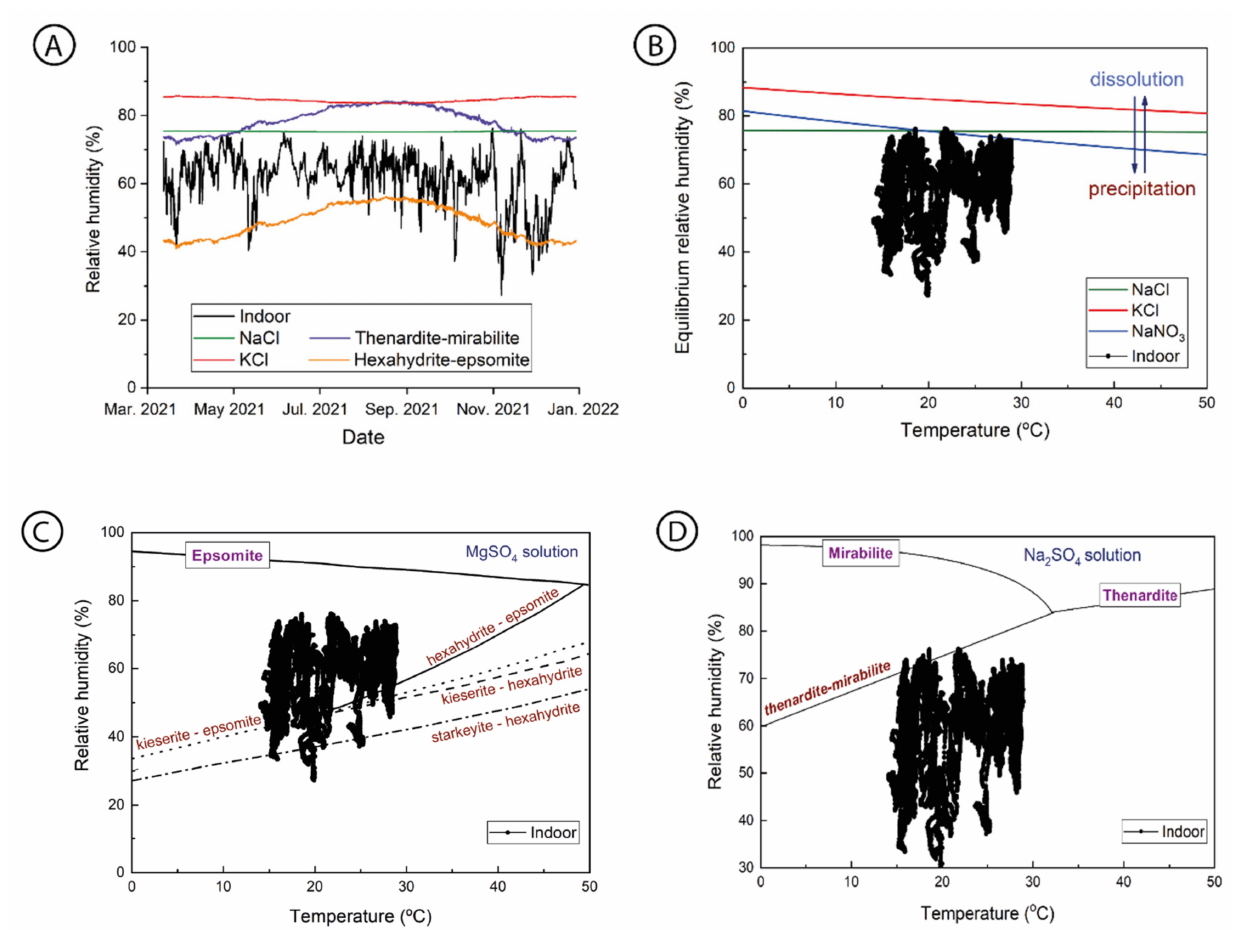
Figure 7. ( A ) Indoor relative humidity and the equilibrium and critical relative humidity for the anhydrous and hydrated mineral phases. Phase diagram of the ( B ) anhydrous salts (halite- NaCl, sylvite-KCl and niter-NaNO 3 ), ( C ) magnesium sulfate (solid line: epsomite-MgSO 4 · 7H 2 O and hexahydrite-MgSO 4 · 6H 2 O; dashed line: hexahydrite-MgSO 4 · 6H 2 O and kieserite-MgSO 4 · H 2 O; dotted line: epsomite-MgSO 4 · 7H 2 O and kieserite-MgSO 4 · H 2 O; dash dotted line: hexahydrite- MgSO 4 · 6H 2 O and starkeyite-MgSO 4 · 4H 2 O), ( D ) sodium sulfate (mirablite-Na 2 SO 4 · 10H 2 O